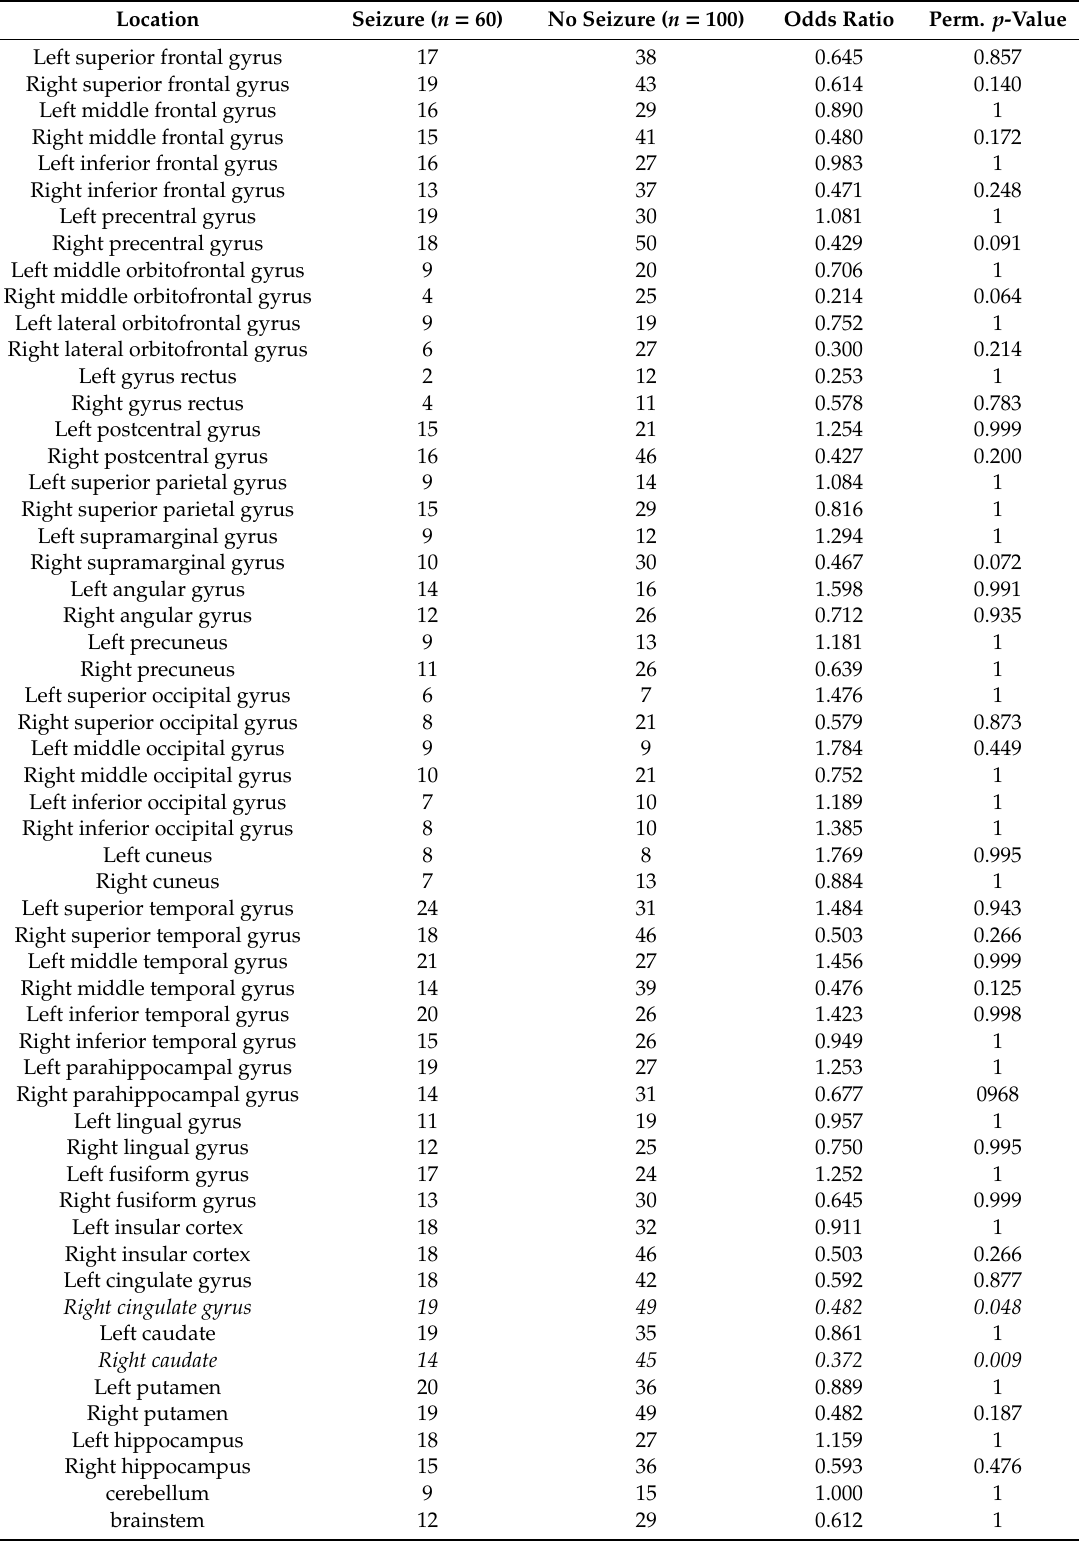
Table 3. Tumor location and